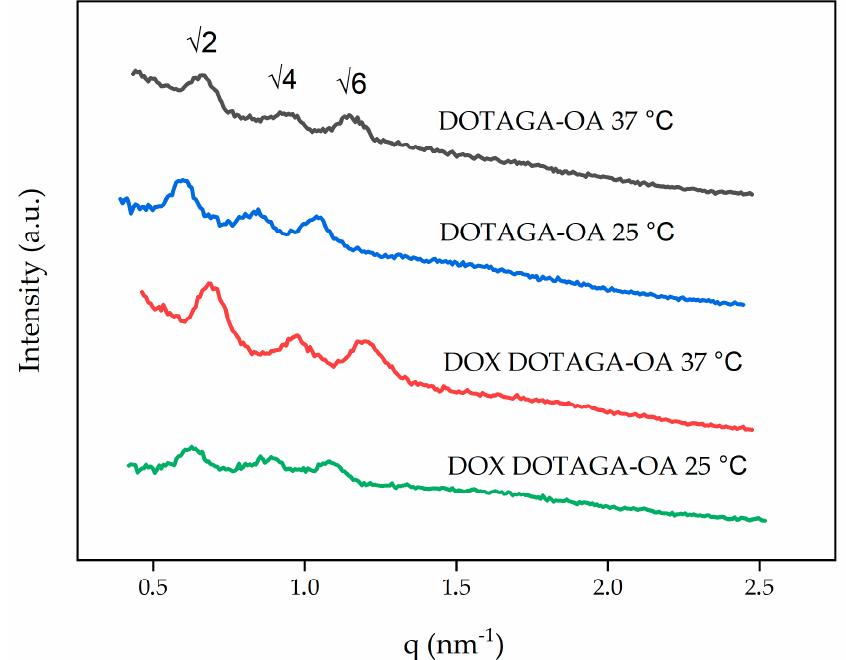
Figure 3. One-dimensional diffraction patterns of cubosome formulations. Table 3. Properties of cubosome formulations determined using SAXS and dynamic light scattering (DLS). Cubosome